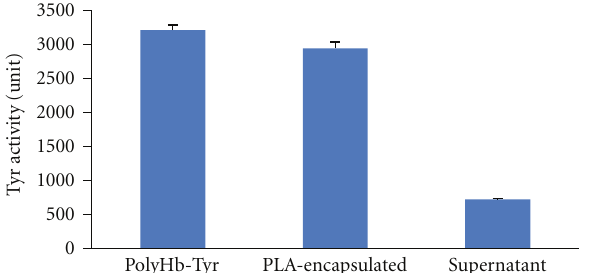
Figure 4: Entrapment e ffi ciency of PLA nanocapsule [polyHb-Tyr].